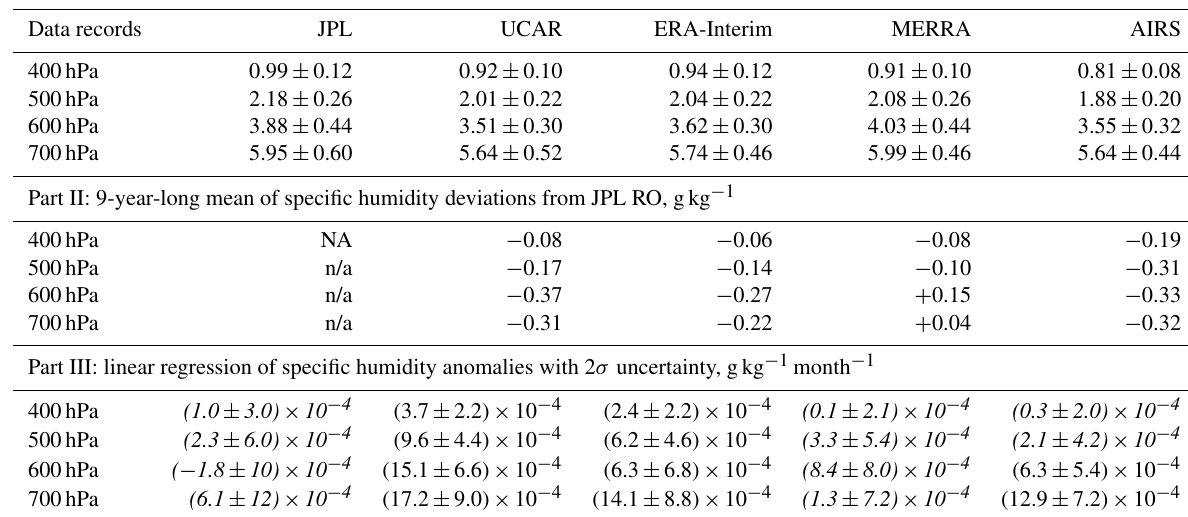
Table 1. Mean climatology, deviation of the mean climatology from JPL, and linear regression fits of the specific humidity time series from JPL, UCAR, ERA-Interim, MERRA, and AIRS over the ± 15 ◦ climate region. The 2 σ uncertainties are estimated for each statistical metric, and their statistical significance is evaluated at p <0.05 confidence level. Values in italic font are statistically